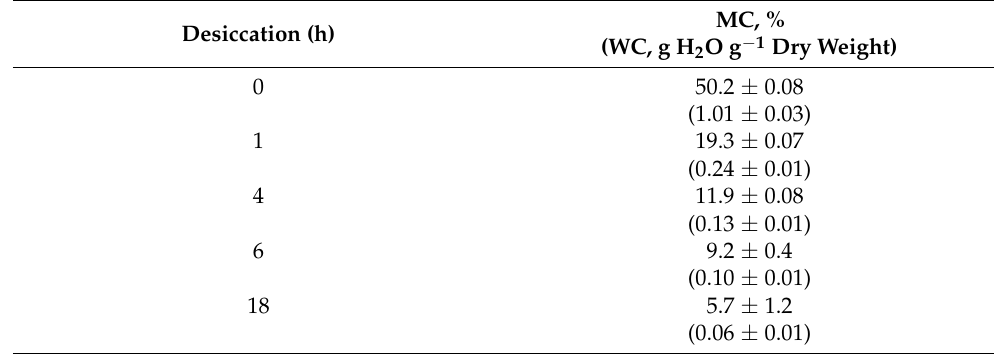
Table 1. Moisture content (MC) and water content (WC) of Acer pseudoplatanus L. embryonic axes after desiccation between 1 and 18